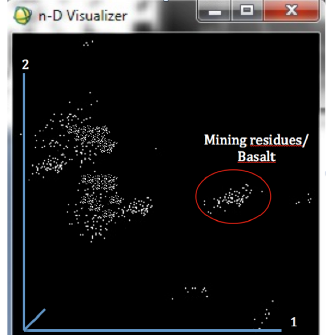
Figure 7. Pixels selected for endmember of the N-dimensional viewer. The projected values are obtained from MNF transformation images.